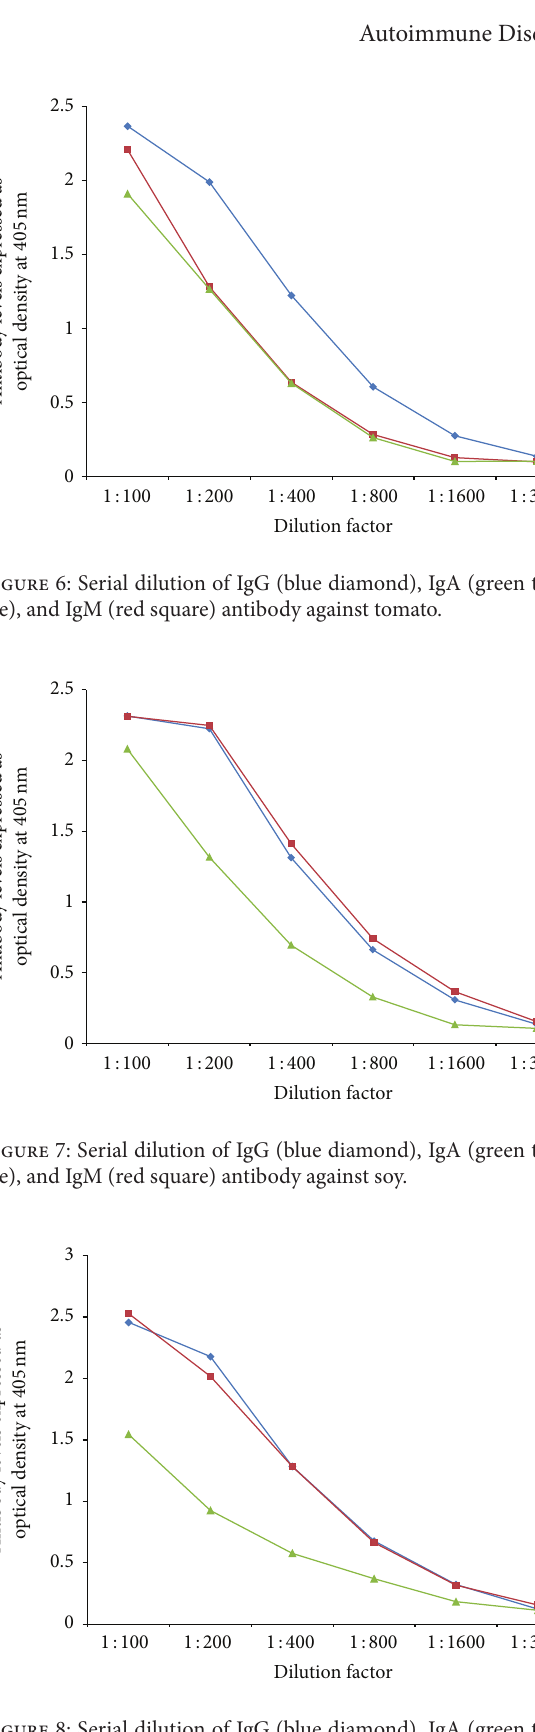
Figure 8: Serial dilution of IgG (blue diamond), IgA (green trian- gle), and IgM (red square) antibody against